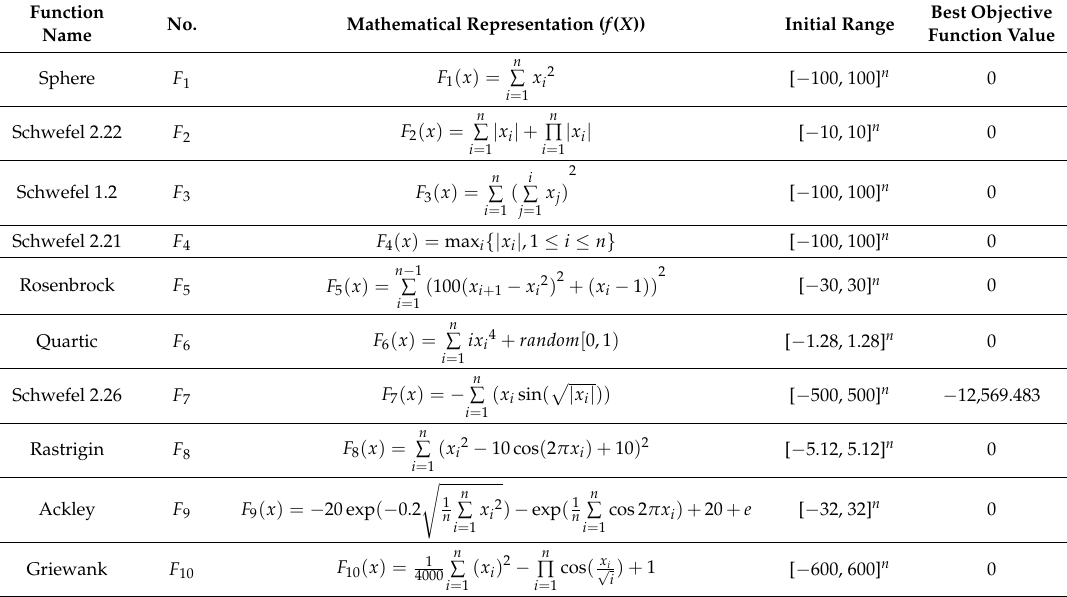
Table 2. Test functions.